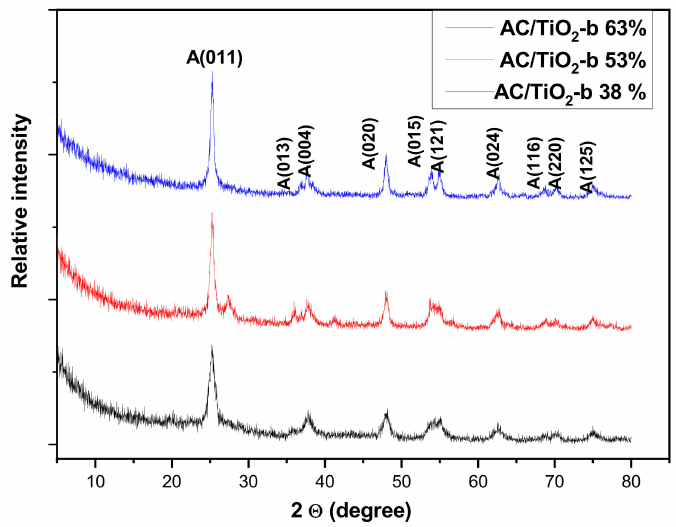
Figure 2. XRD patterns of the AC/TiO 2 ball